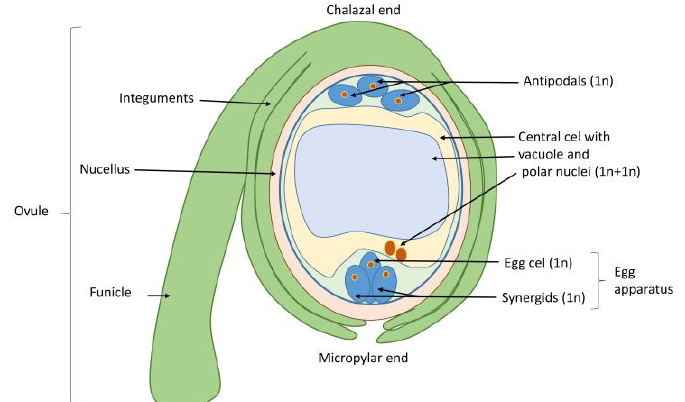
Figure 5. Schematic drawing of the ovule of higher plants, containing female gametophyte (embryo sac). Development of the embryo sac takes place in tissues embedded within the ovule attached to the maternal tissues by funicle. The embryo sac is situated within the body of the nucellus, which is covered by integuments. The mature embryo sac consists of four types of cells: the egg cell and the two synergids (egg apparatus) at the micropylar end, the antipodals at the chalazal end and the central cell containing the two polar nuclei and a large vacuole. 1n — haploid nucleus.